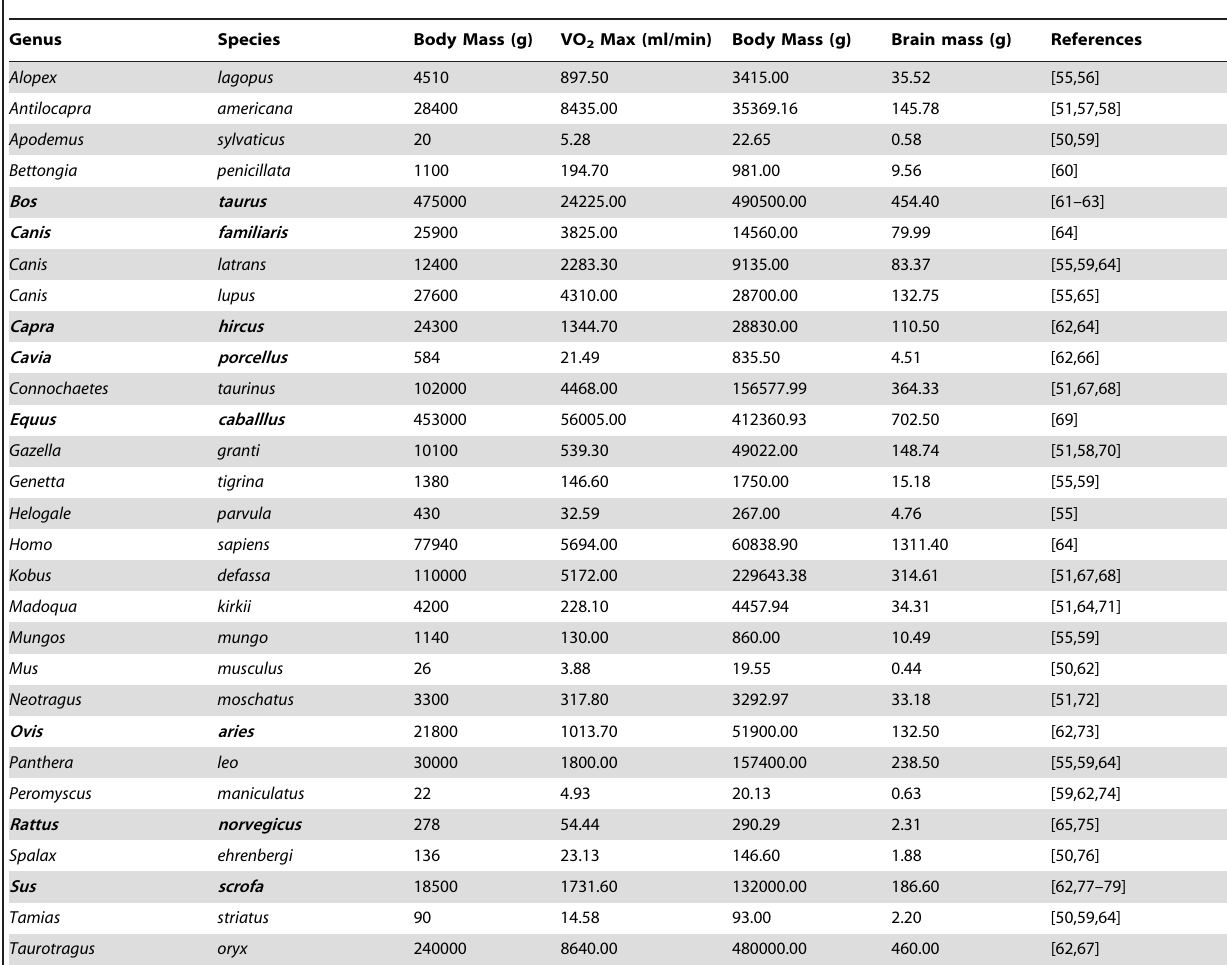
Table 1. Brain mass and MMR